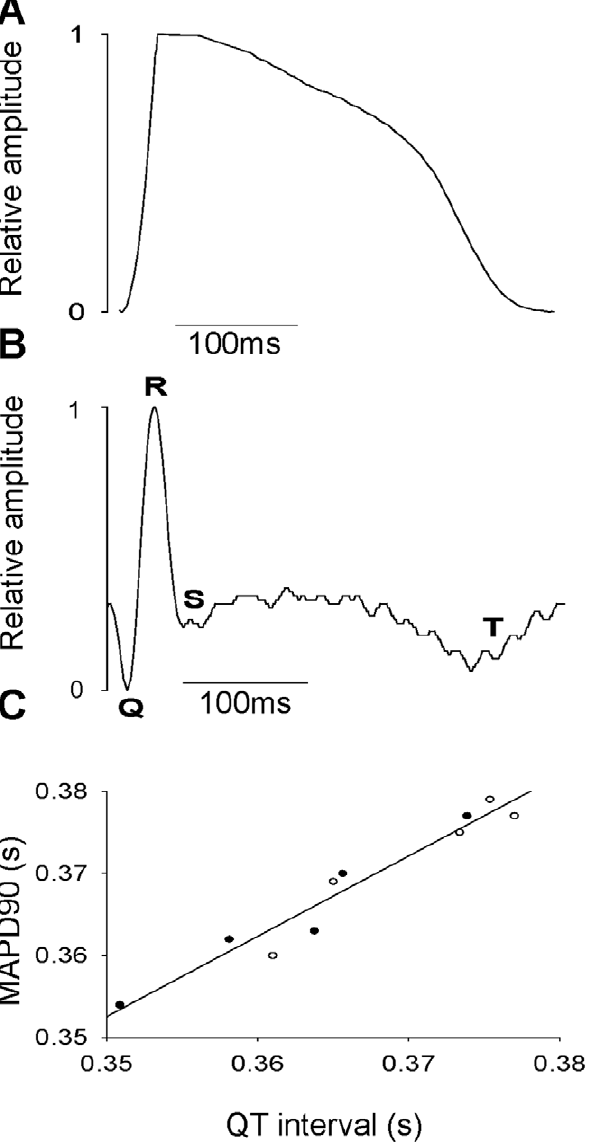
Figure 2. ECGs and MAPs recorded simultaneously from the same fish heart. (A) A MAP recorded from a fish heart extrinsically paced at 0.8 Hz at 11 u C. (B) A QT segment from an ECG recorded simultaneously from the same heart. The QRS complex and T-wave are labelled. Note that the QT interval of the ECG trace and the repolarisation time of the MAP are virtually identical. (C) The QT interval of the ECG plotted against average MAPD recorded simulta- neously from both spontaneously beating (black circles, n=5) and paced hearts (open circles n=5). The gradient of the line is close to unity with a high correlation coefficient (r=0.97).